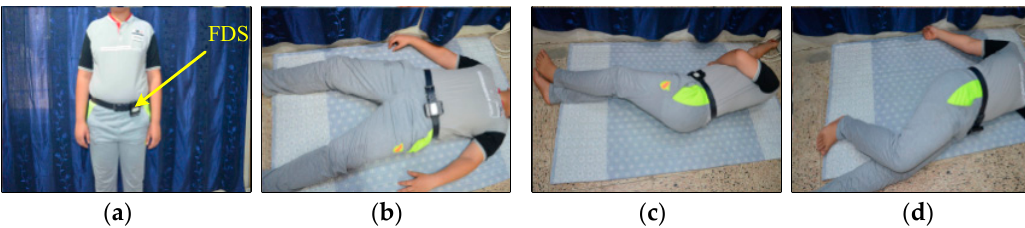
Figure 13. Different postures: ( a ) standing, ( b ) backward fall, ( c ) right-side fall, and ( d ) left-side fall. Table 3. Fall detection accuracy of the proposed sensor-based approach.